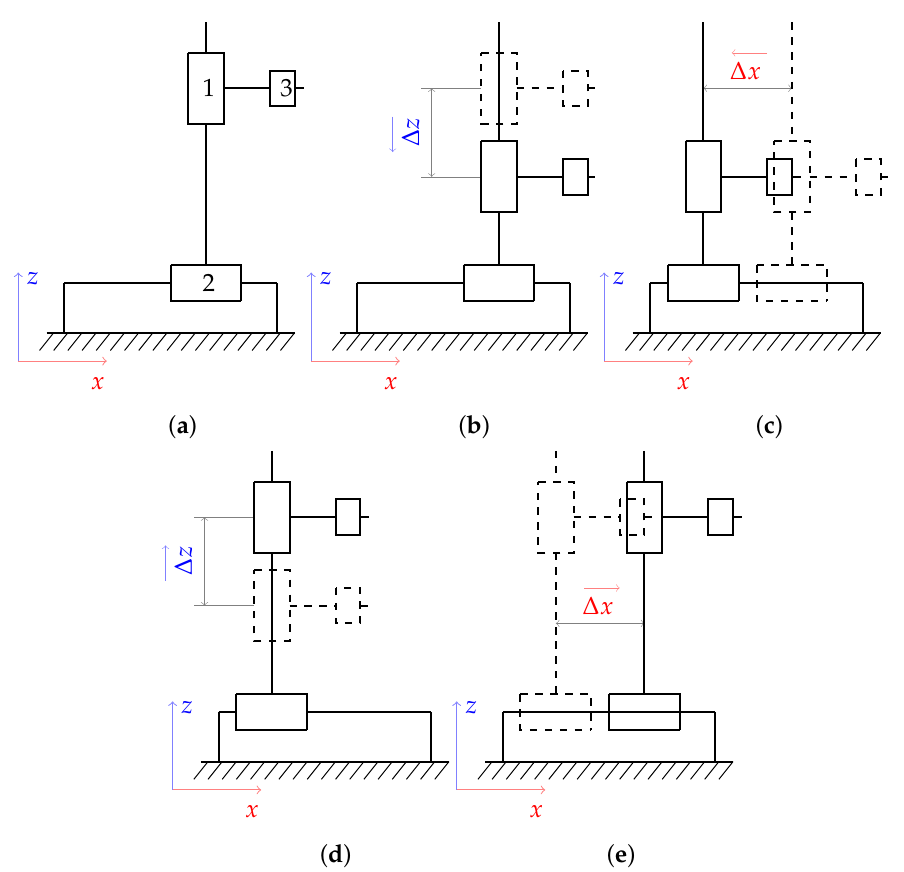
Figure 3. Simplified schematic of the robot’s movement. Subfigure ( a ) presents the initial state of the mechanism, where: 1 is the translation joint of axis z ; 2 is the translation joint of axis x ; and 3 is the end effector. Subfigures ( b – e ) present the successive stages of the robot’s translation-joints’ movement. The string is plucked halfway the movement presented in ( b